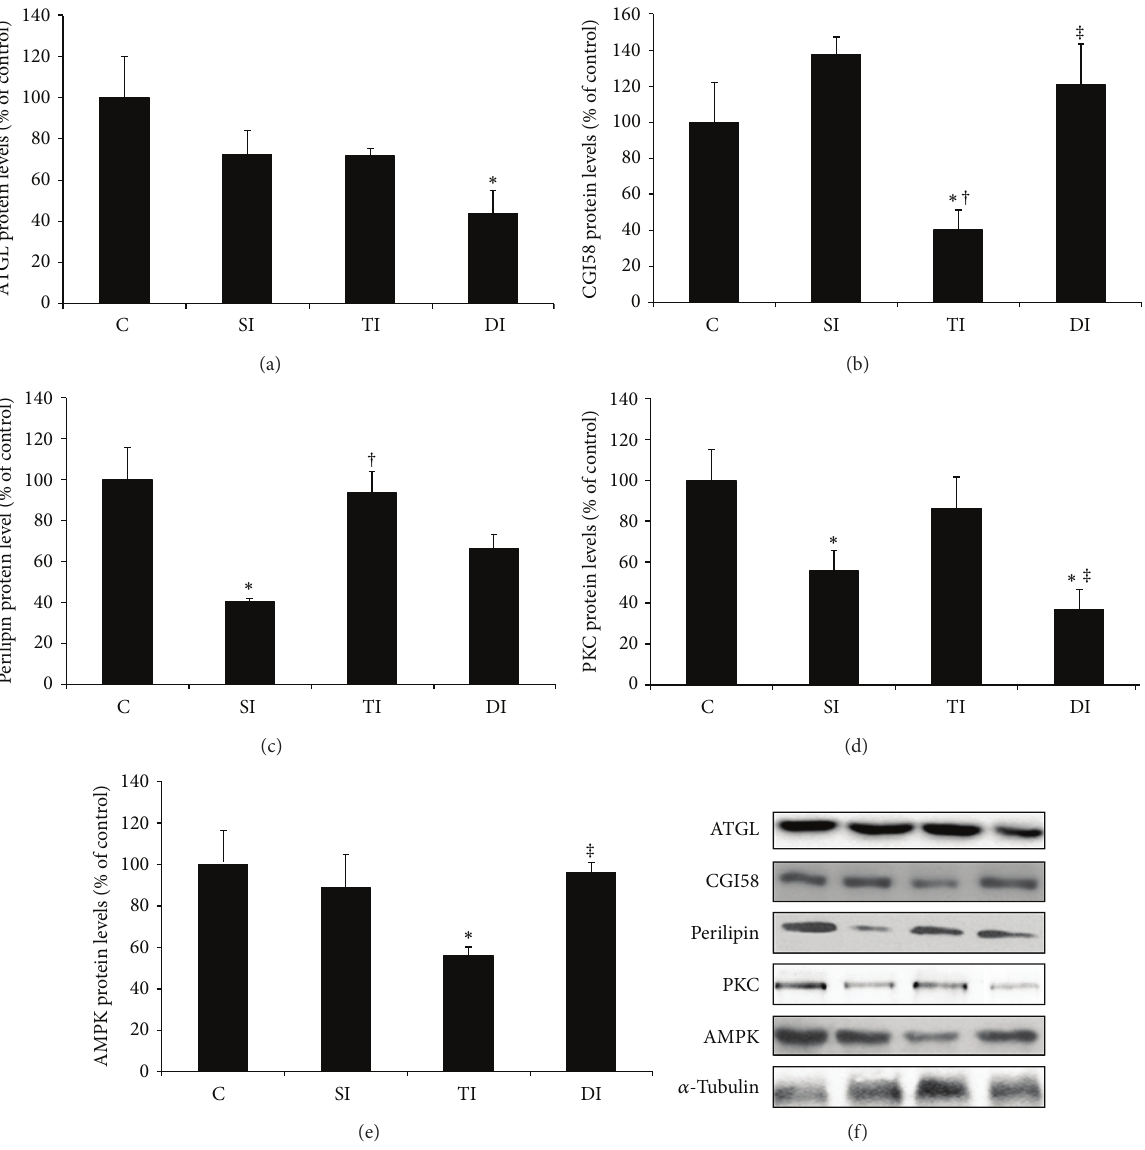
Figure 5: Protein levels of ATGL, CGI58, perilipin, PKC, and AMPKon epididymal adiposetissue of control (C), sedentary infarcted (SI), trained infarcted (TI), and detrained infarcted (DI) rats. ∗ 𝑃 < 0.05 versus C; † 𝑃 < 0.05 versus SI; ‡ 𝑃 < 0.05 versus TI.